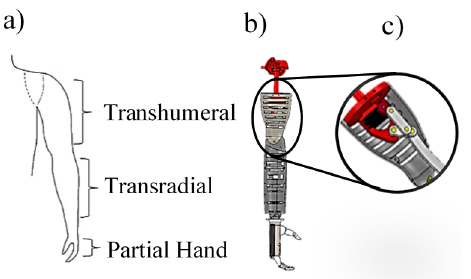
Figure 8. The methodology used to optimize parts.